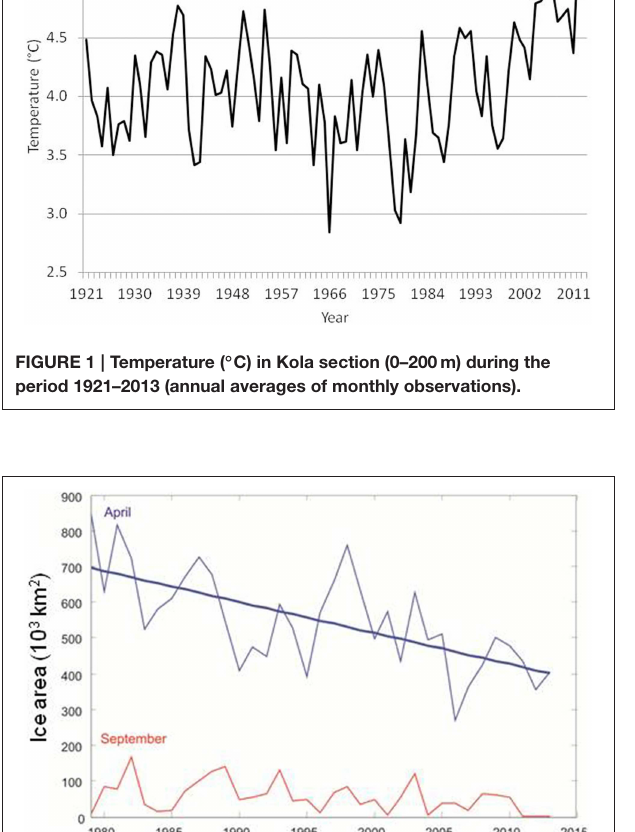
Frontiers in Ecology and Evolution |